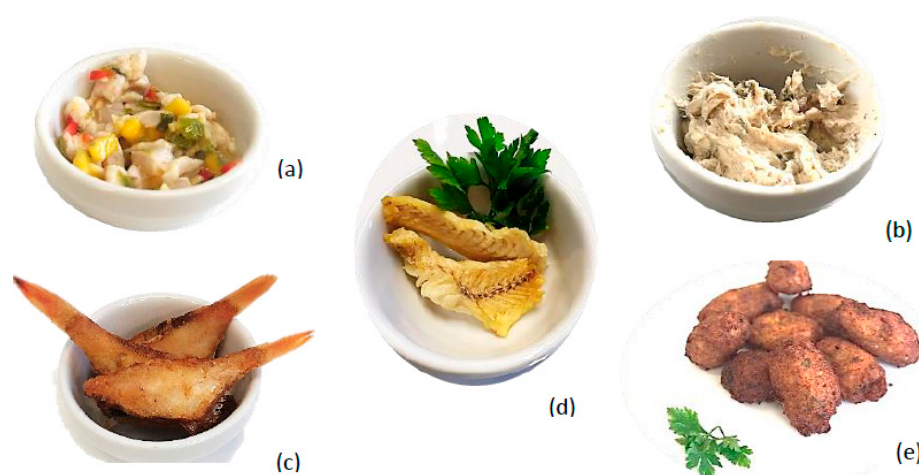
Figure 1. Reformulated fish products developed with each species. Legend: ( a ) black seabream ceviche, ( b ) smoked blue jack mackerel pâté, ( c ) fried boarfish, ( d ) dehydrated piper gurnard, and ( e ) comber pastries. Adapted from [1].